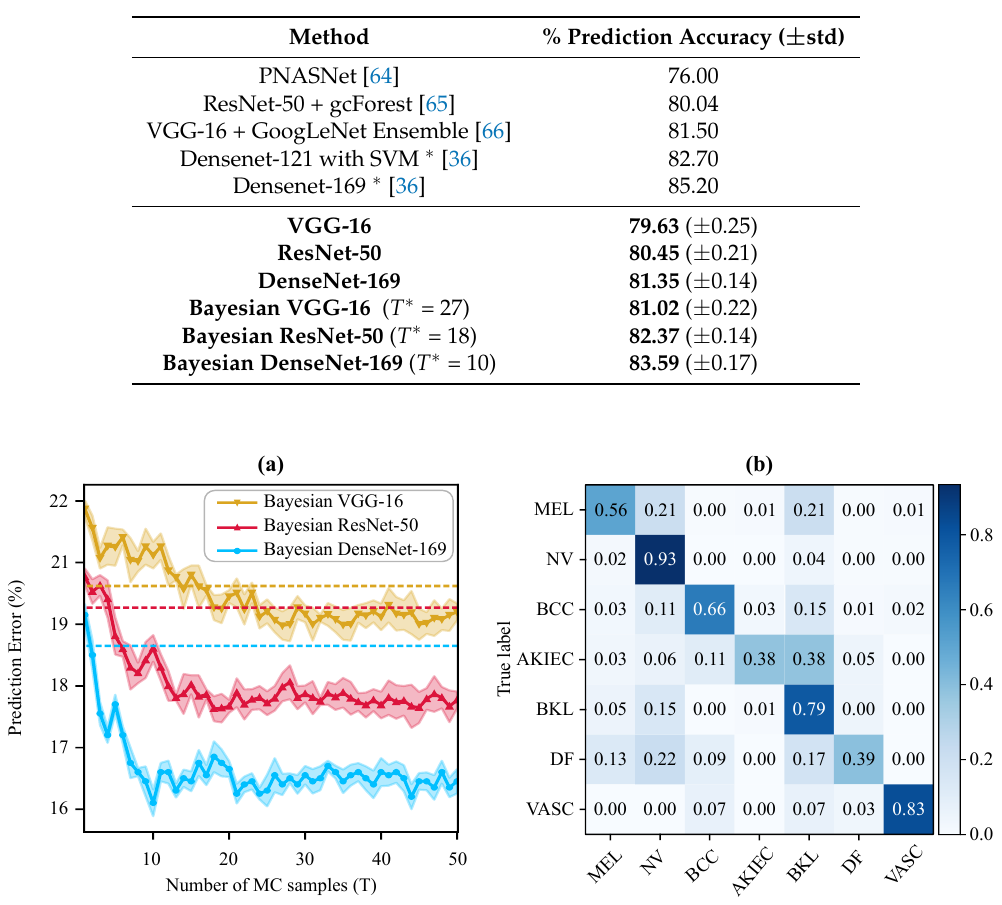
Table 2. Quantitative comparison of the implemented models in skin lesion classification of HAM dataset. The ∗ sign on some models shows that auxiliary processing stages and methods were exploited to improve the performance. Our models are shown in bold. T ∗ represents the required number of Monte Carlo simulations to achieve the best performance in the Bayesian networks.